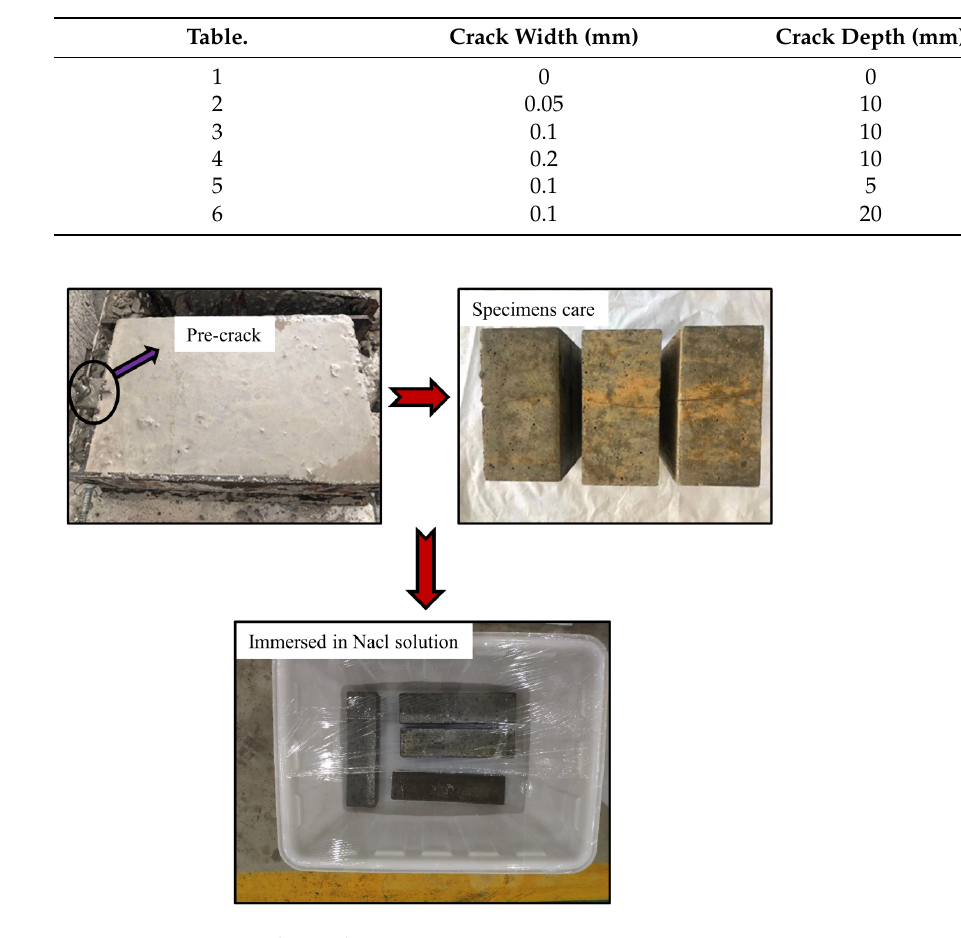
Figure 5. Concrete specimen sampling. 2.3. Results and Discussion 2.3.1. Effect of Crack Width and Length on Chloride Distribution The chloride migration experiments were terminated after 90 days. The chloride con- centration profiles in the middle of specimens (i.e., cracked sections) are shown in Figure 6 for a series of crack widths (Figure 6a) and depths (Figure 6b). The chloride content in concrete is based on the percentage of cement weight. The chloride content decreases with increasing depth. Figure 6a shows the chloride profiles for crack widths of 0 mm (i.e.,